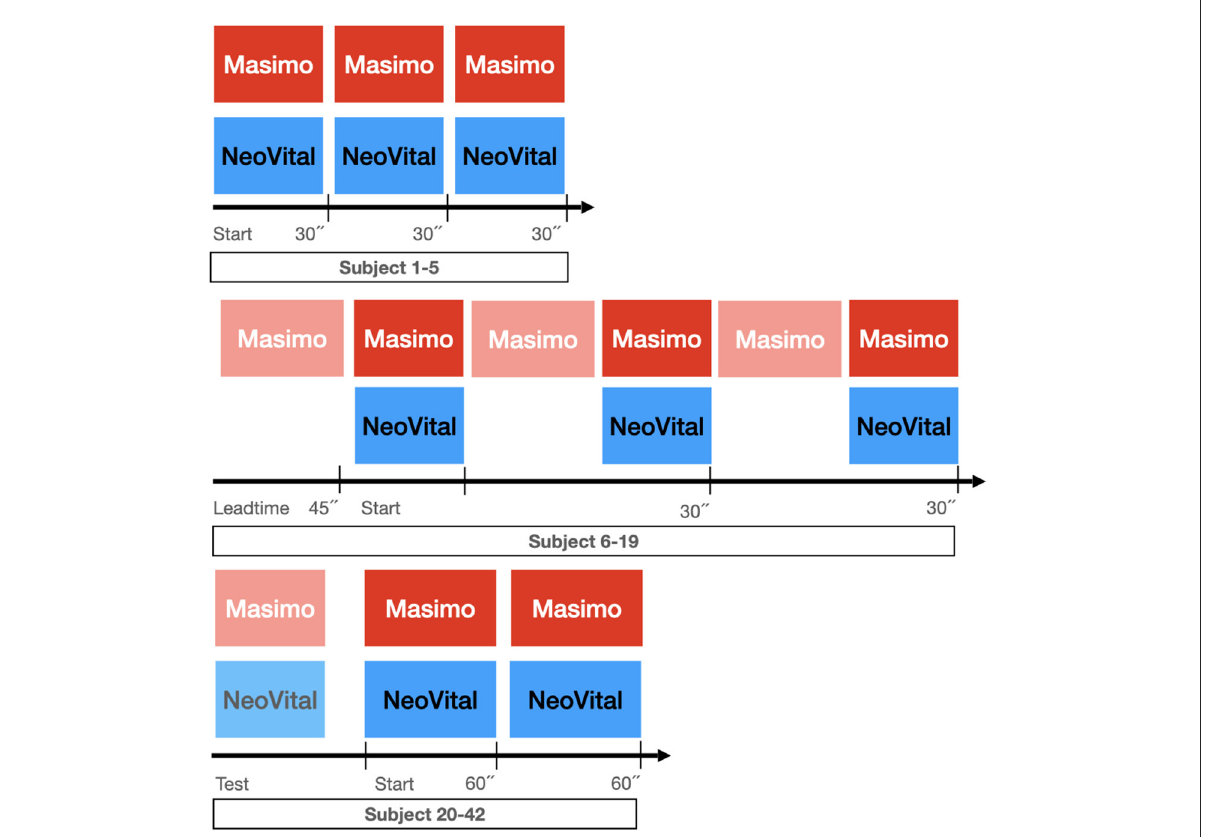
FIGURE4 Adapted measurement time scale based on procedural evaluated application